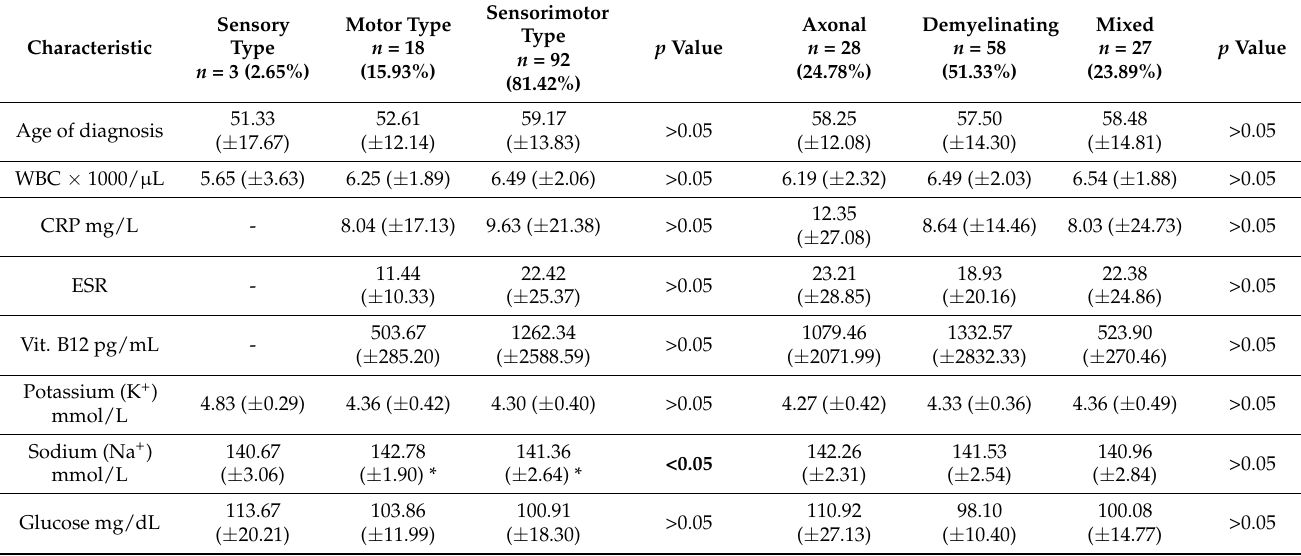
Table 3. Comparison of laboratory test results for the type of fiber involvement and the type of damage.